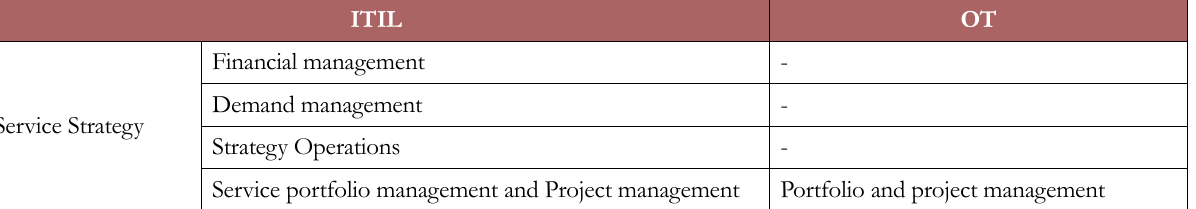
Table 3. High-level service strategy ITIL - OT mapping